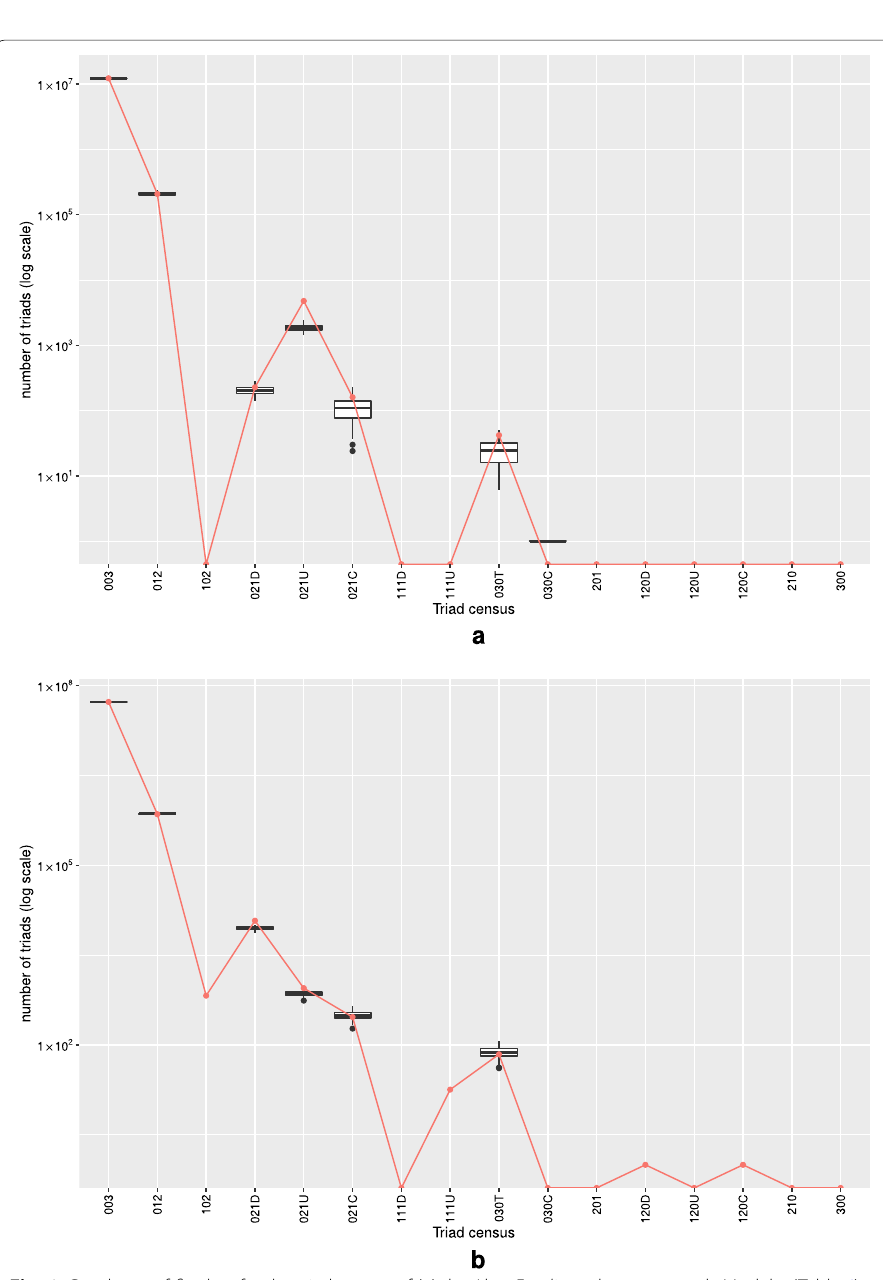
Fig. 6 Goodness-of-fit plots for the triad census of ( a ) the Alon E. coli regulatory network, Model 1 (Table 6), and ( b ) the Alon yeast regulatory network, Model 1 (Table 7). The observed triad counts are plotted in red with the triad counts of 100 simulated networks plotted as black boxplots. Because the triad counts ( y -axis) are on a log scale, values of zero are omitted (observed zero counts shown as a red point on the bottom of the graph). In ( a ), for triad census class 030C (cyclic triad), the “box plot” consisting of a single median line for the simulated count represents a single (out of 100 simulations) occurrence of a nonzero count (of 1)